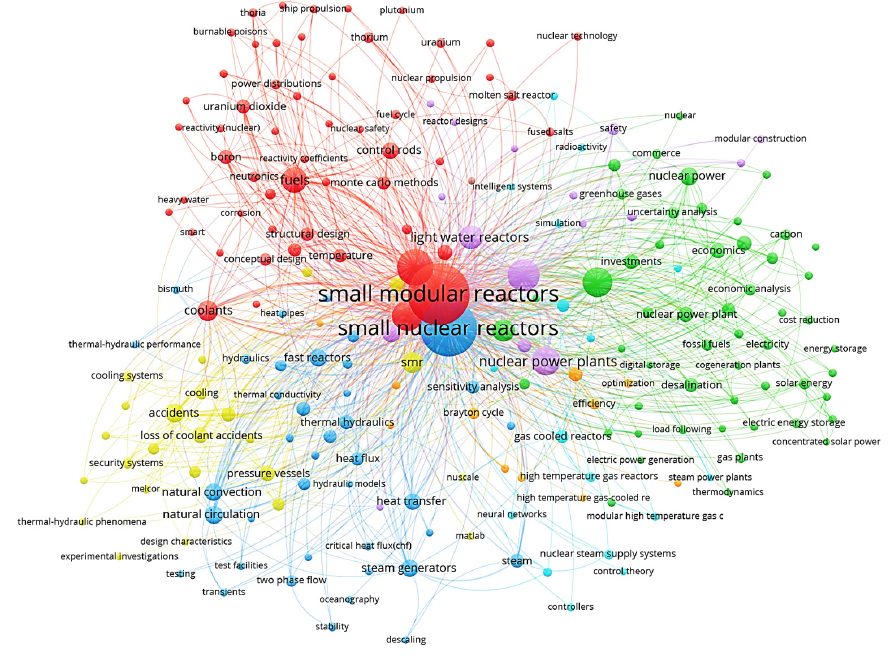
Figure 5. Network map for “SMR” and “Nuclear”.